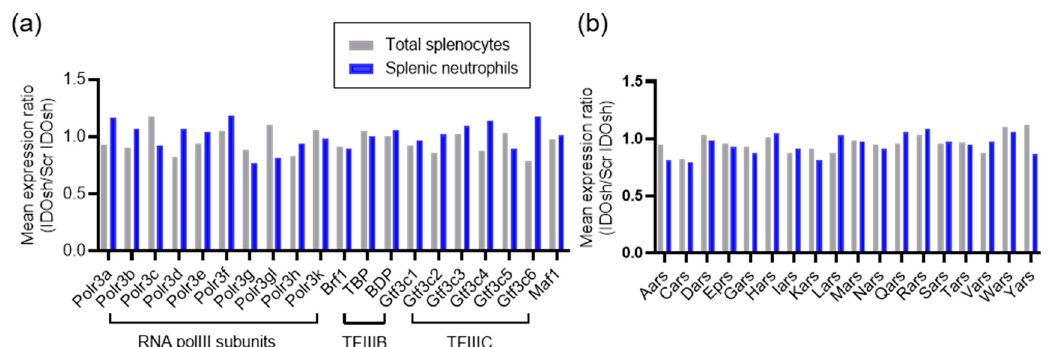
Figure 5. The potential regulatory genes of tRNA transcription. ( a ) The expression of RNA polymerase III machinery, including the subunits of RNA polymerase III (RNA polIII), transcription factor for polymerase III B (TFIIIB), and TFIIIC. ( b ) The expression of aminoacyl-tRNA synthetase genes. The official gene symbol of each aminoacyl-tRNA synthetase gene is shown on the label of x - axis in this figure.